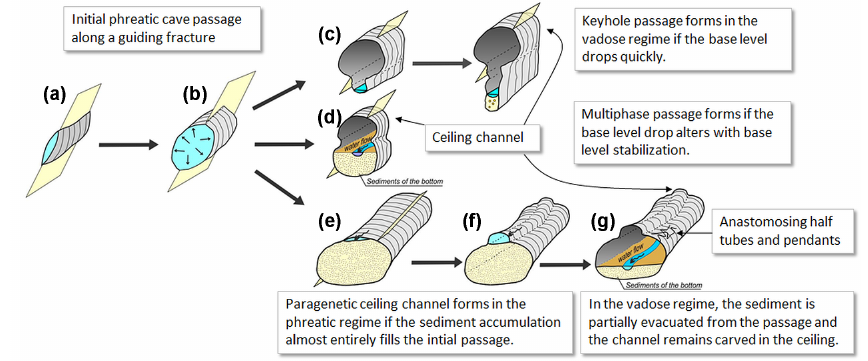
Figure 1. Schematic evolution of the passages in phreatic and vadose hydrological regime under conditions of high sediment flux and following abandonment (modified after Farrant and Smart, 2011). Further description of the stages is Sect.